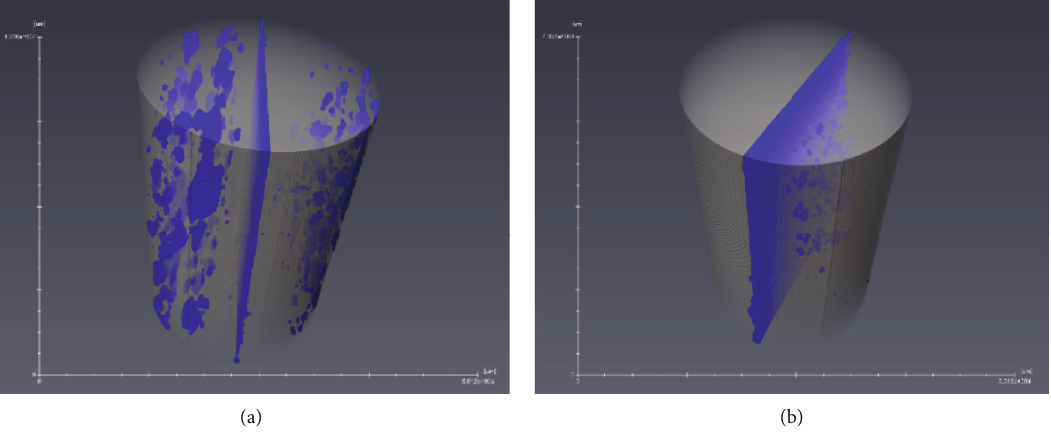
Figure 3: CT scan of the core after acidizing in Group